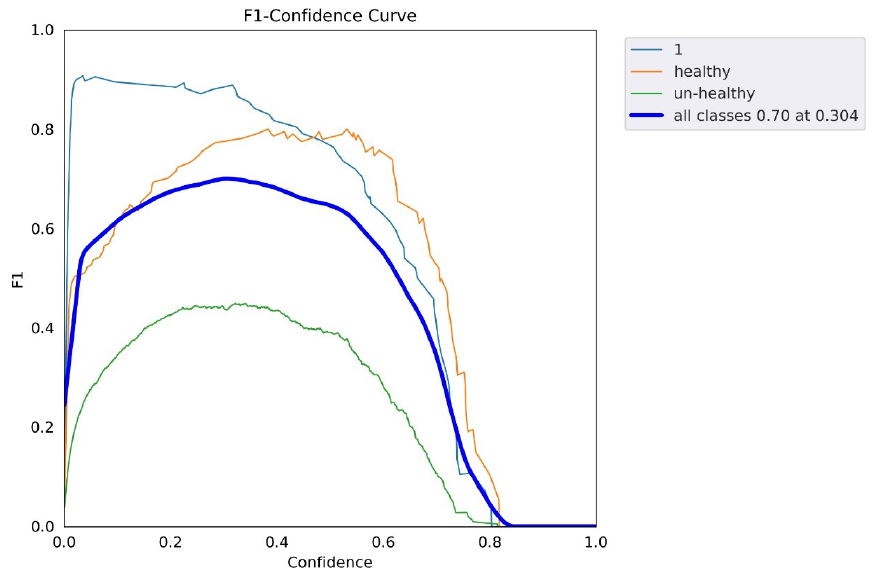
Figure 26. F1 confidence curve: Comparison of progression of mean F1 score across all experiments, grouped by training mechanism.